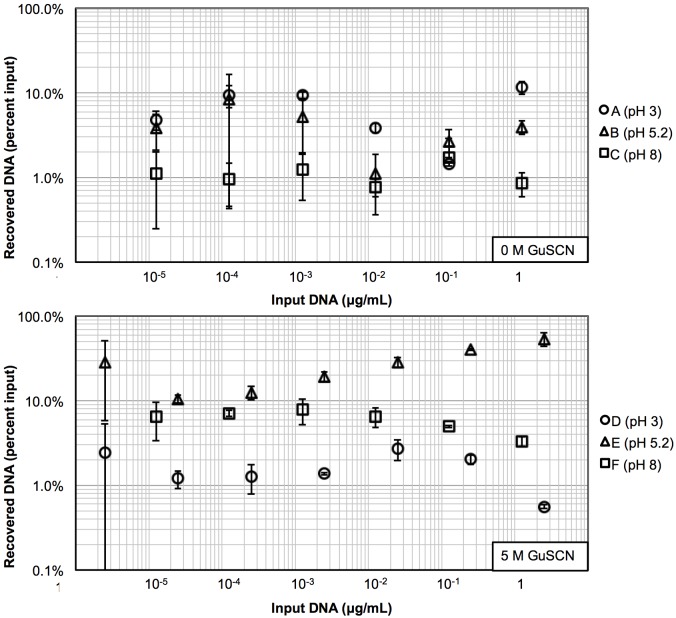
Recovered DNA with buffer EB elution from silica.The plots show DNA recovered from the silica surface after DNA incubation with each adsorption solution. Solutions tested at pH 3, 5.2, and 8 are labeled as circles, triangles, and squares respectively, and solutions D, E, and F also contained 5 M GuSCN. All samples were eluted with buffer EB (10 mM Tris-Cl pH 8.5). (n = 3).